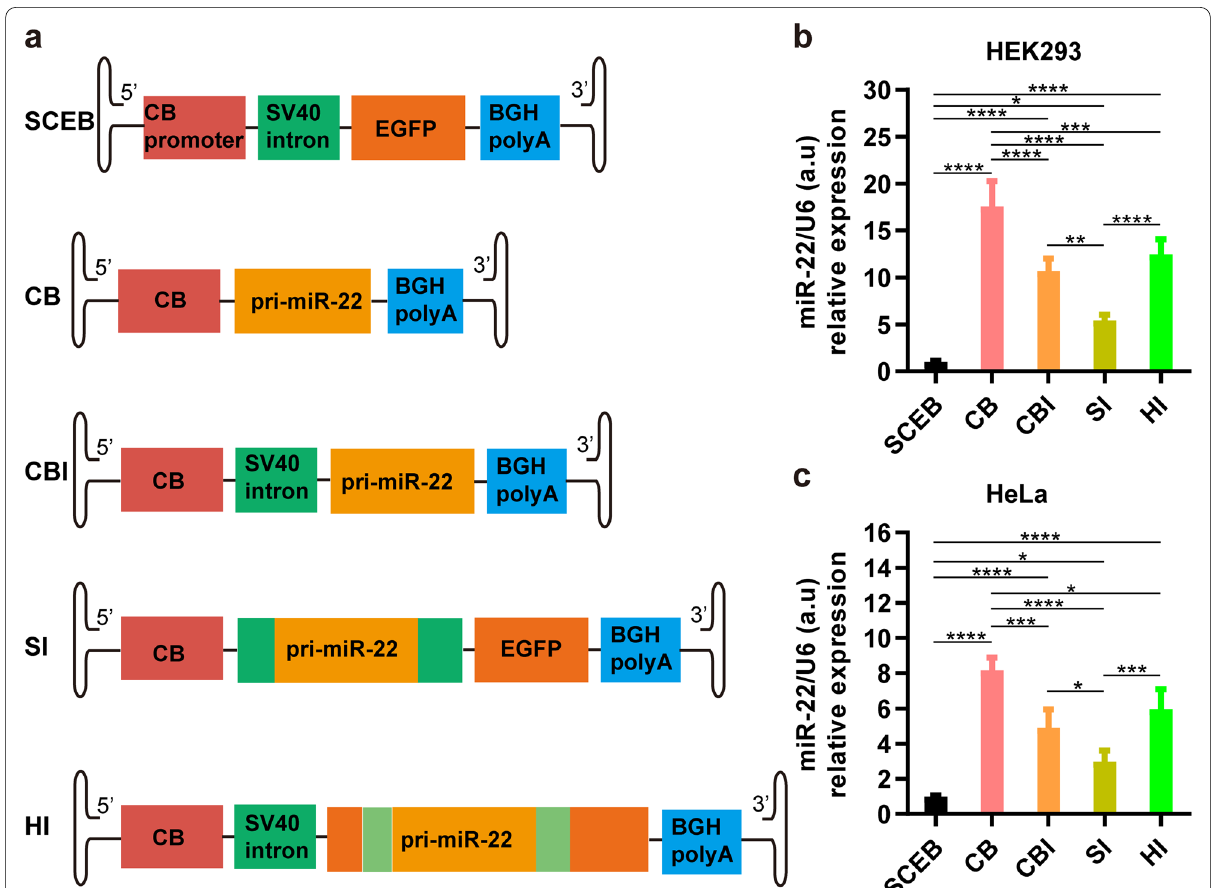
Fig. 3 Effect of the intron position on miR-22 overexpression in cells. a Schematic pictures of miR-22 expression cassettes in the rAAV vector plasmids with pri-miR-22 at different positions relative to an intron or introns. Two boxes in light green on both sides of pri-miR-22 in HI vector indicated separate parts of another intron named hCG intron from the hCG gene. b miR-22 expression levels in HEK293 cells. c miR-22 expression levels in HeLa cells. n 4, error bars represent the standard deviation of the mean. * P < 0.05, ** P < 0.01, *** P < 0.001, and **** P < =